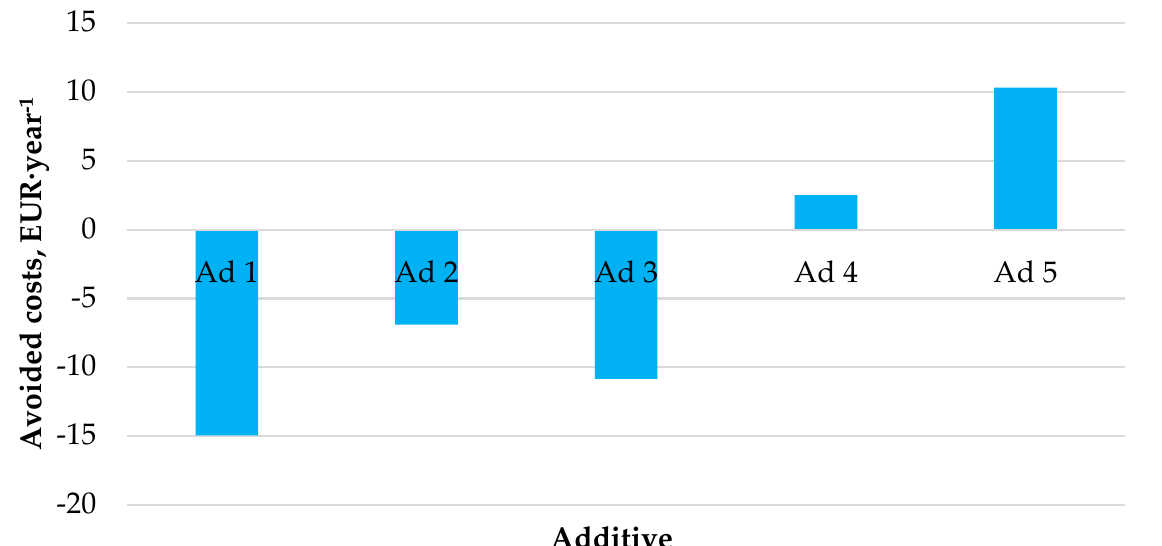
Figure 5. Expected amounts of avoided costs by the co-combustion of hemp pellets with catalytic additives.